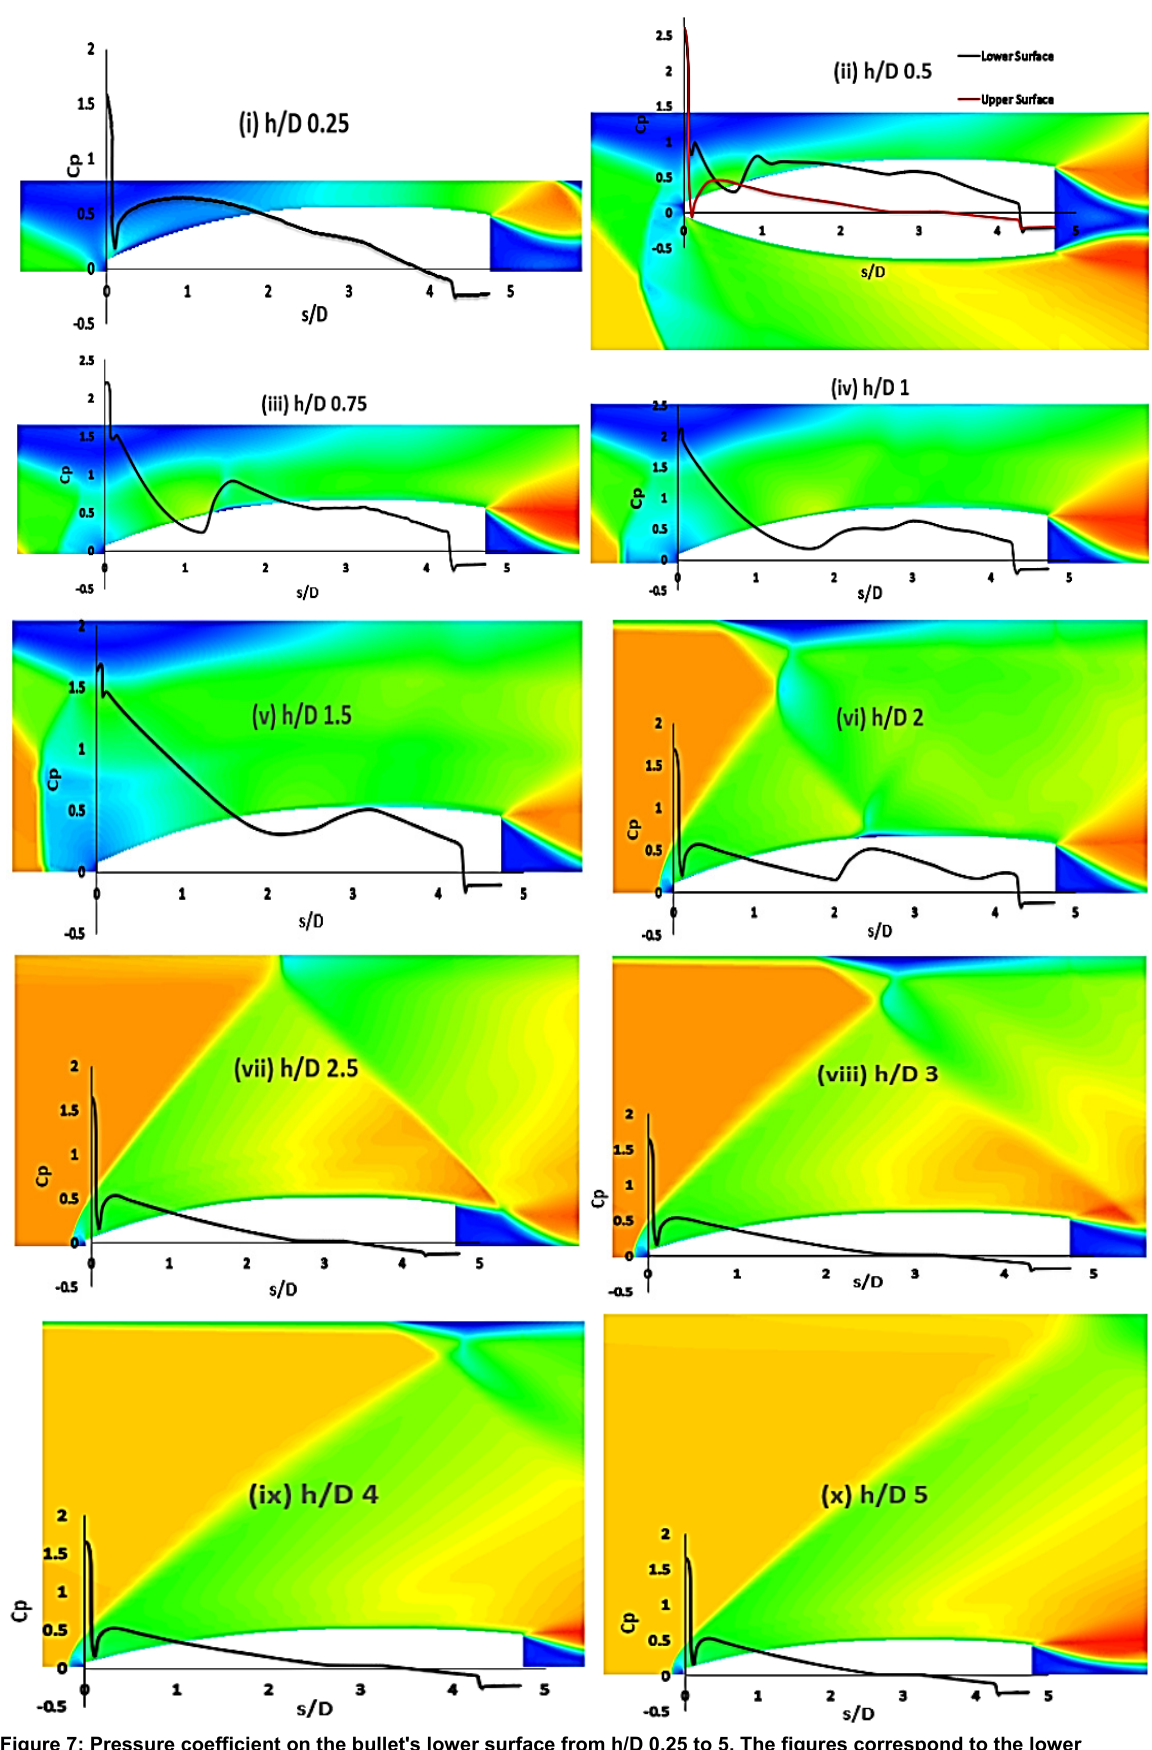
Figure 7: Pressure coefficient on the bullet's lower surface from h/D 0.25 to 5. The figures correspond to the lower surface, and the top line represents a wall. h/D 0.5 shows the surface pressure distribution on the upper surface has no significant impact due to the shock